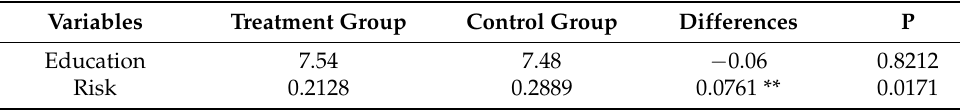
Table 11. Test for differences in means. Variables Treatment Group Control Group Differences P Education 7.54 7.48 − 0.06 0.8212 Risk 0.2128 0.2889 0.0761 **